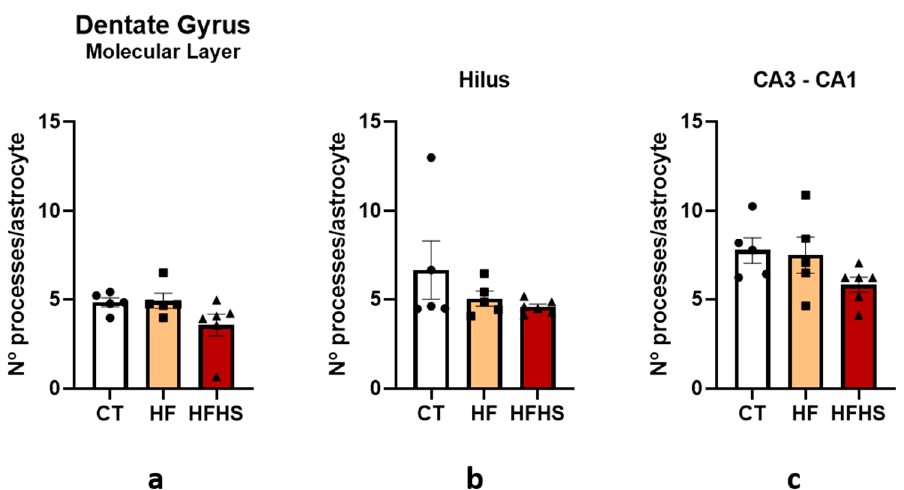
Figure 13. Histograms showing the mean ± SD number of processes per astrocyte in the molecular layer ( a ), hilus ( b ), and CA3-CA1 ( c ) region of the hippocampus. There were no significant differences among the three groups. The bars in white represent the mean for the control group, the bars in orange represent the mean for the HF group, and the bars in red represent the mean for the HFHS group. The circle represents the value for each animal in the control group, the square represents the value for each animal in the HF group, and the inverted triangle represents the value for each animal in the HFHS